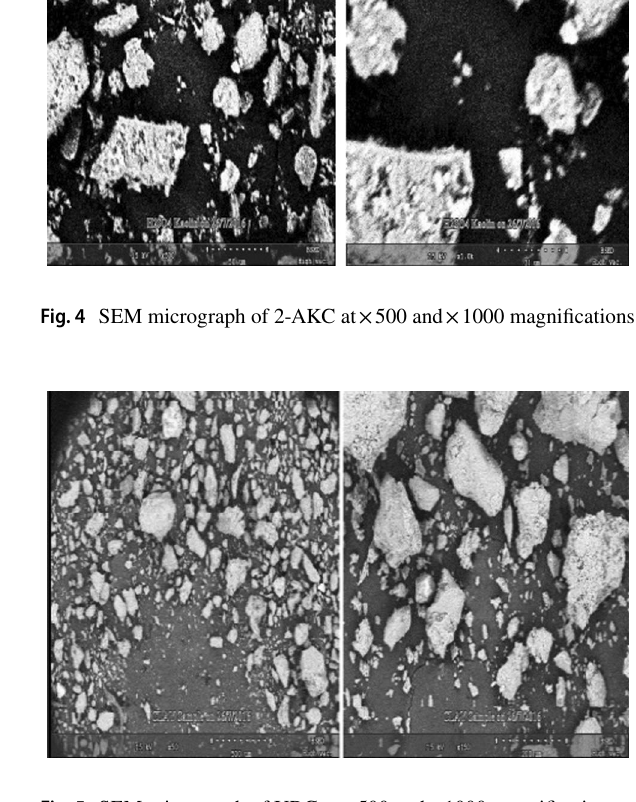
Fig. 5 SEM micrograph of UBC at × 500 and × 1000